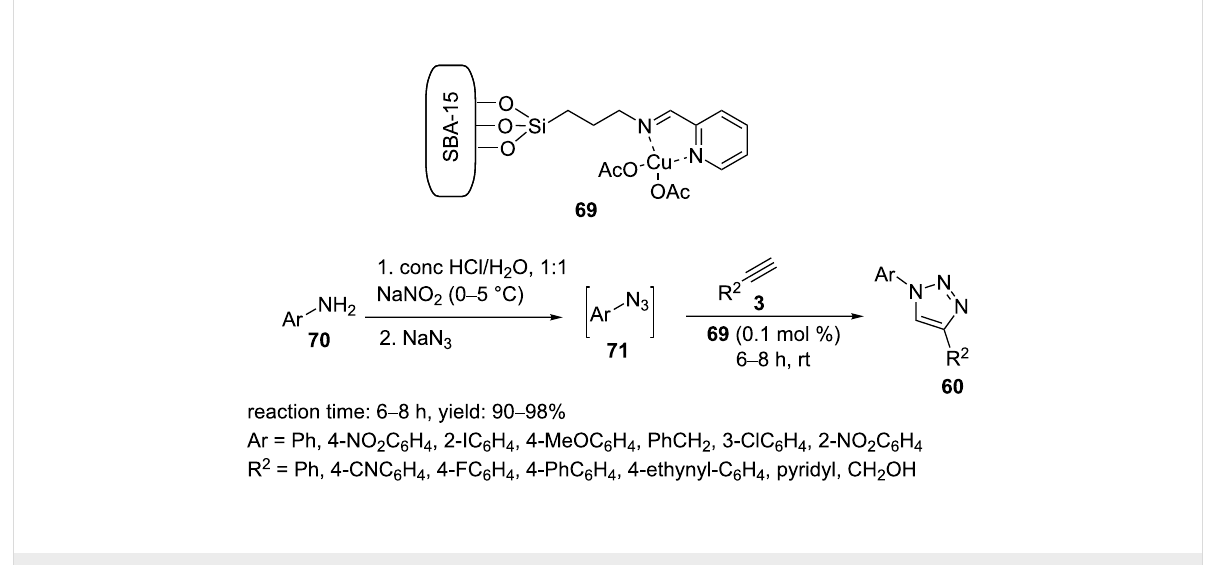
Scheme 12: Chemical structure of the catalyst 69 and catalytic application of 69 in “click”